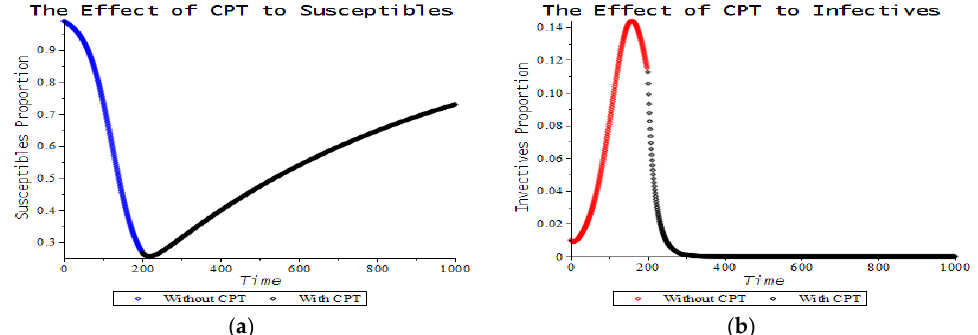
Figure 5. Graphs of the SEIR model assuming the “do nothing” decision during the time interval (0, 200), followed by the implementation of CPT with the rate proportional to the number of infectives. The graph in ( a ) shows the dynamics of the susceptibles, while the graph in ( b ) shows the dynamics of the infectives.